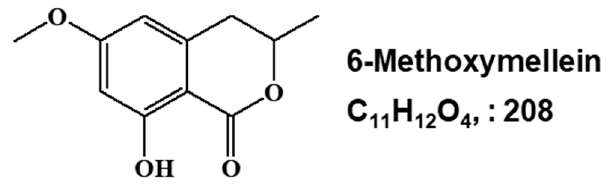
Figure 2. Chemical structure of the CSC inhibitor isolated from carrots. Chemical structure of 6- methoxymellein.